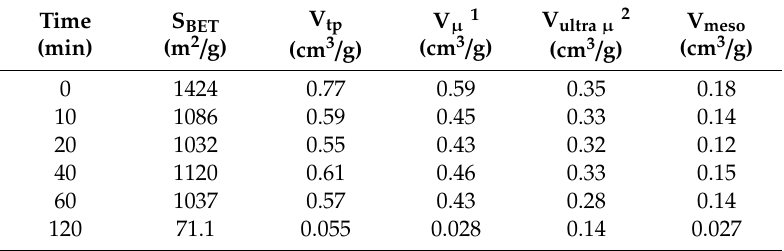
Figure 7. Porous texture characterization of untreated ACC and hybrid Pani-ACC composites synthesized after di ff erent electropolymerization times: ( a ) N 2 adsorption–desorption isotherms; ( b ) Brunauer-Emmett-Teller (BET) surface area; ( c ) Pore volume distribution: micropore volume (open circles), ultramicropore volume (open diamonds), mesopore volume (open triangles). Table 1. Porous texture analysis of as-received ACC and hybrid PAni-ACC composites synthesized after di ff erent electropolymerization